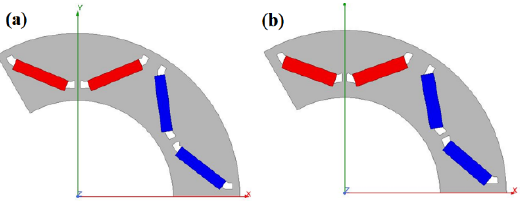
Figure 7. Optimization analysis results of the rotor design ( a ) before and ( b ) after the optimization process.